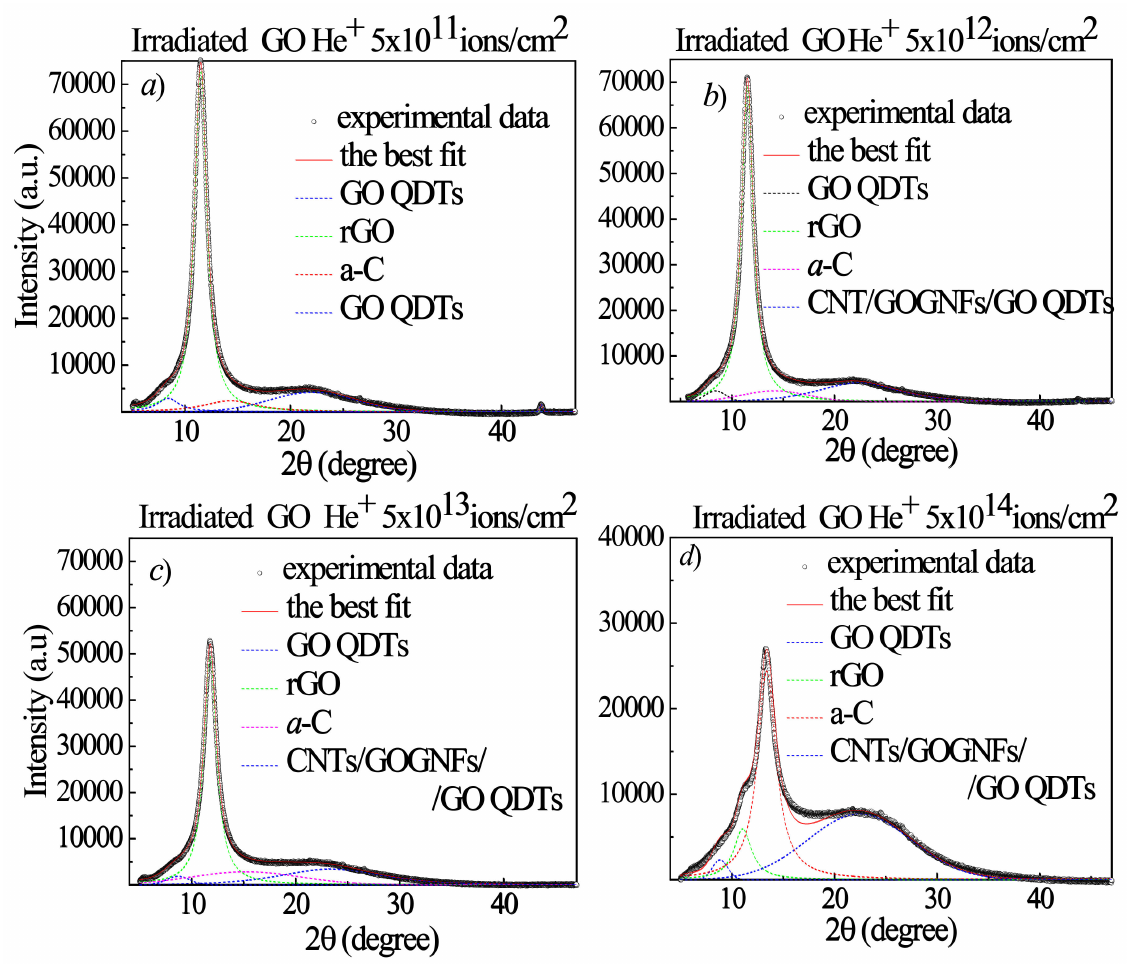
Figure 14. 2 θ / ω XRD curves of the GO foils irradiated with 3 MeV He + beams at increasing absorbed dose ( a – d